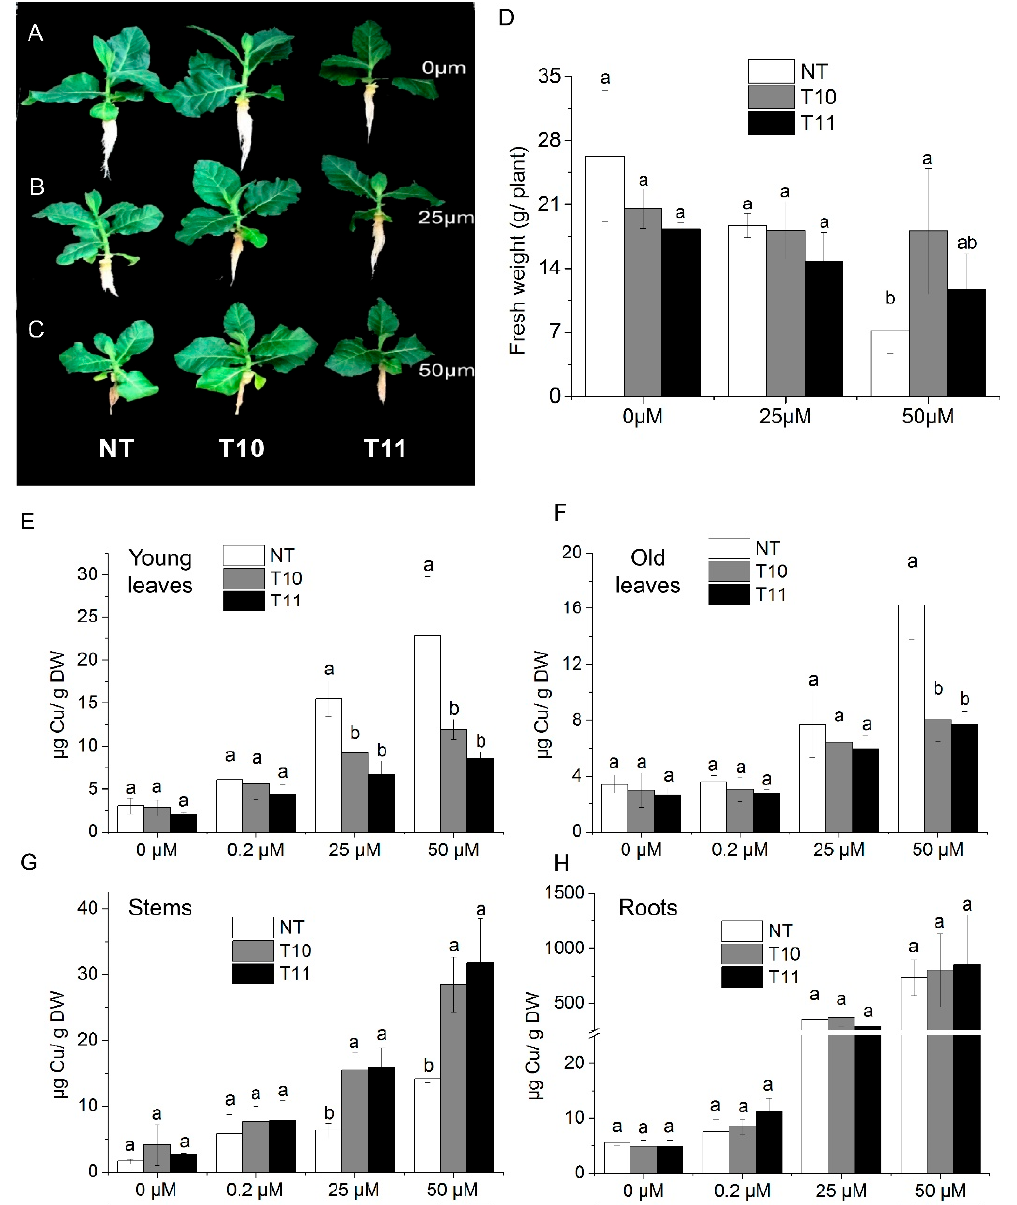
Figure 5. Transgenic tobacco plants expressing AhYSL3 . 1 exhibited enhanced tolerance to excess Cu. ( A – C ) Phenotypes of transgenic tobacco plants expressing AhYSL3 . 1 in response to excess Cu. The Cu. ( A – C ) Phenotypes of transgenic tobacco plants expressing AhYSL3.1 in response to excess